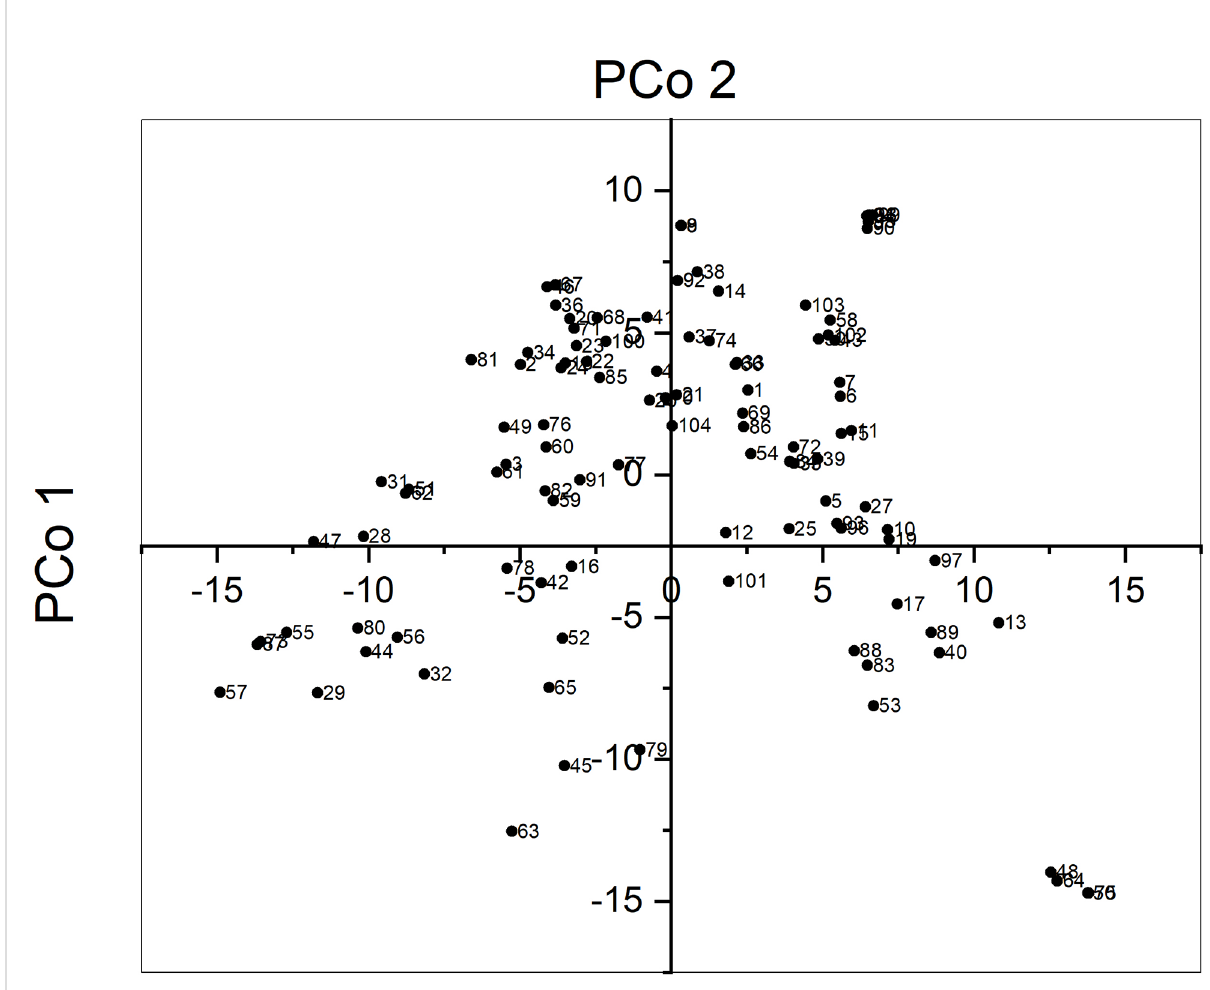
FIGURE 1 Principal coordinate analysis of 104 sun fl ower accessions genotypes with SNP